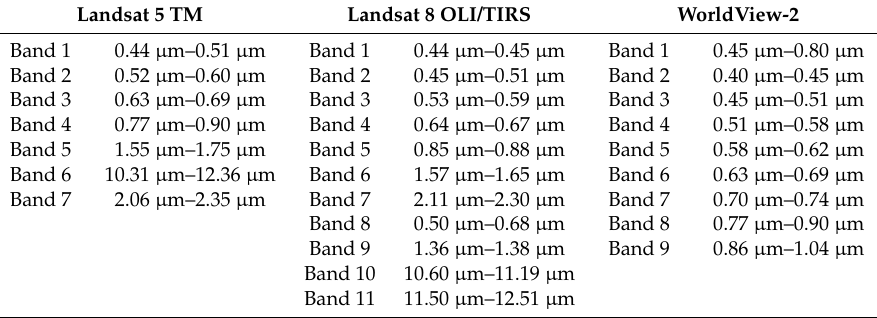
Table 1. Bands of Landsat7 ETM, Landsat 8 OLI /TIRS and WorldView-2 [61,62]. Landsat 5 TM Landsat 8